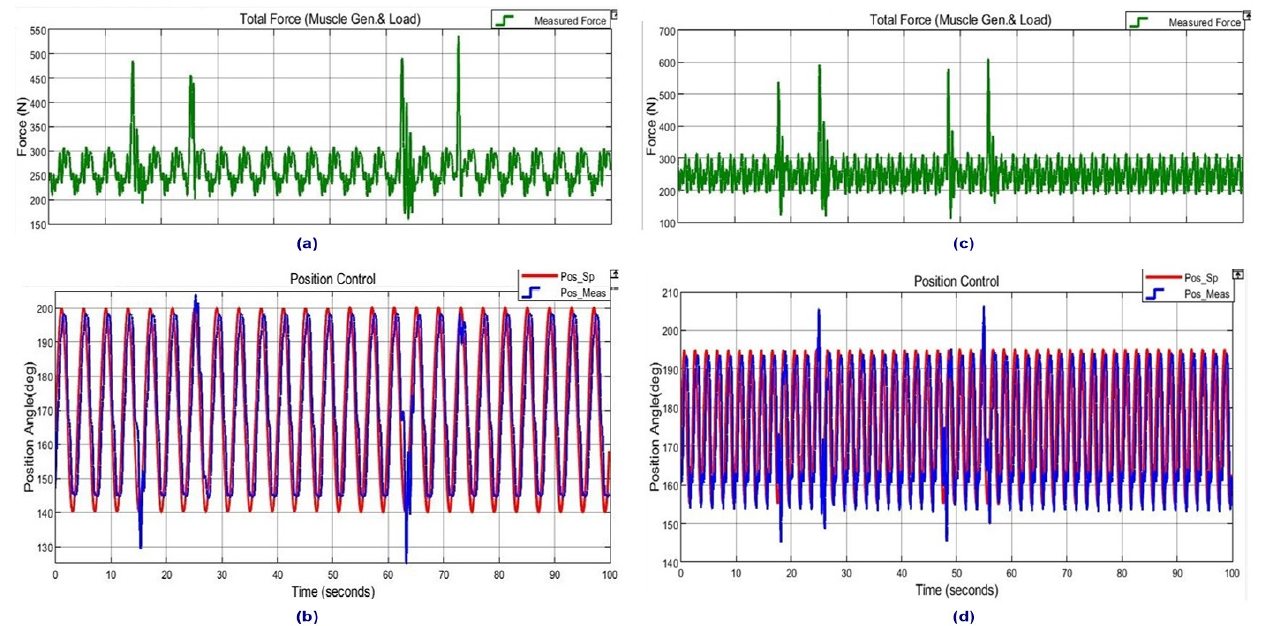
Figure 26. Impulsive force load application and system responses at 0.25 Hz ( a , b )and 0.50 Hz sinusoidal trajectory tracking ( c , d ).